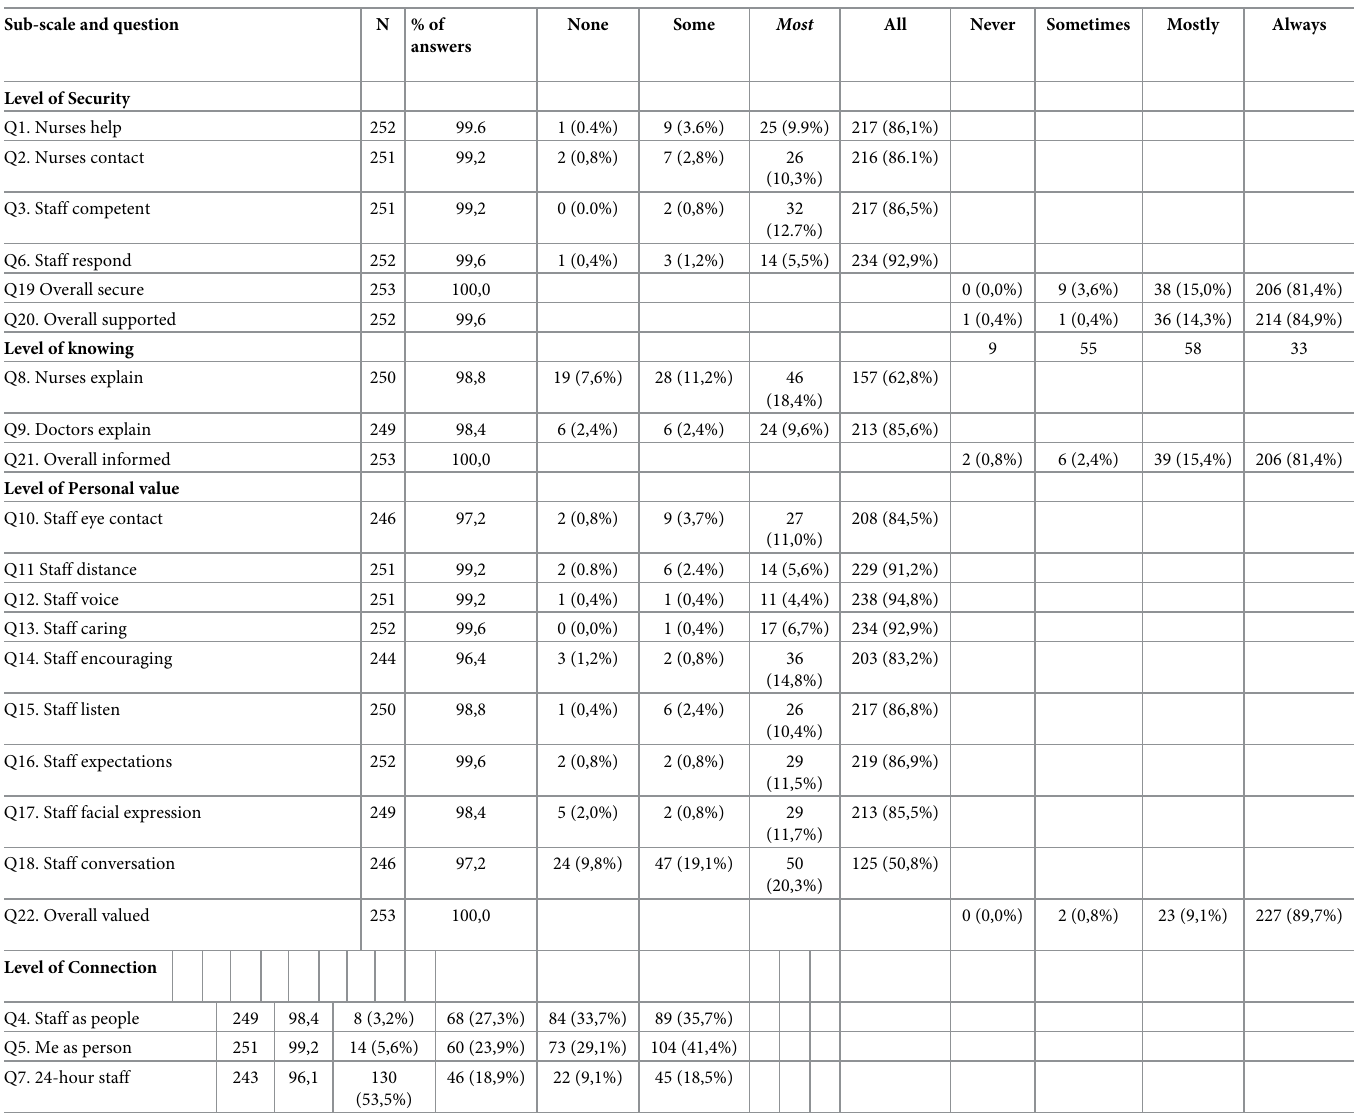
Table 4. Frequency of answers to questions.